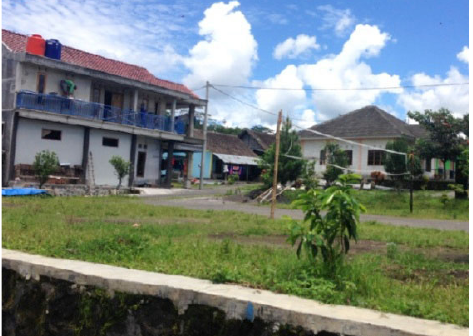
Figure 1. Siteplan housing